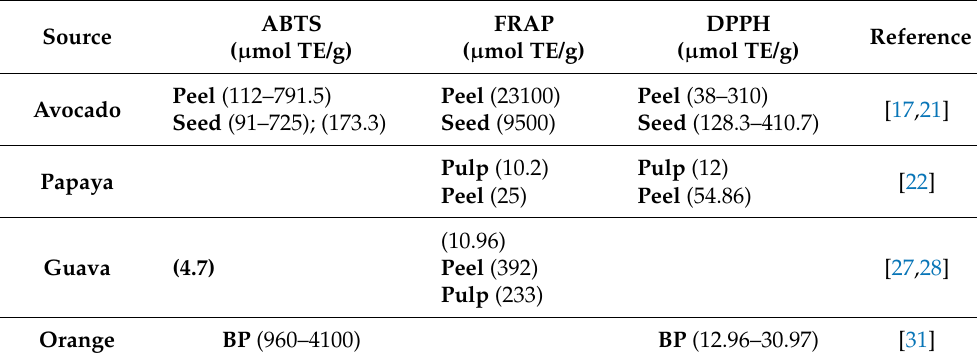
Table 2. Antioxidant activities of fruit pulp, byproducts, and dietary fiber concentrates